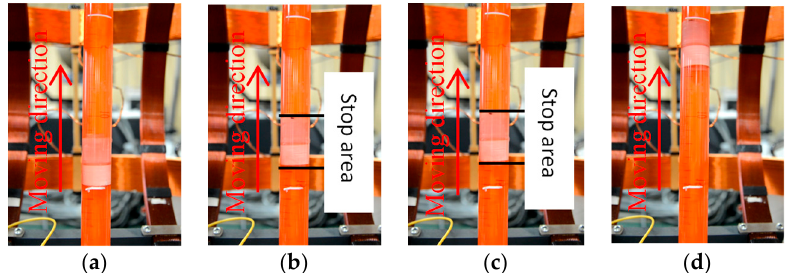
Figure 18. Experimental setup ( a ) Phase 1; ( b ) Phase 1; ( c ) Phase 1; ( d ) Phase 1.